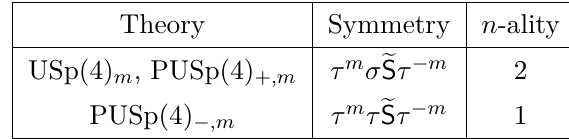
Table 13 . (Non-)invertible symmetries for the case of usp (4) at τ YM = i/